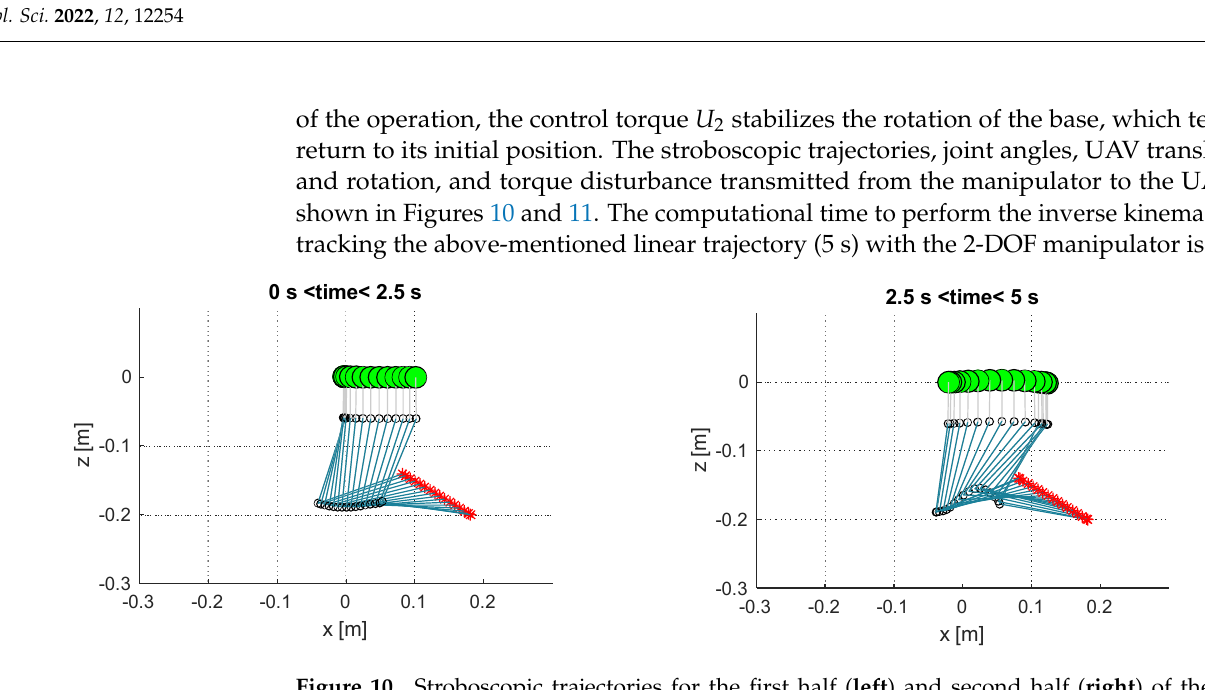
Figure 11. Manipulator ( top ) and UAV motions and torque disturbance ( middle and bottom ) for the 2-DOF UAM using the generalized Jacobian with external forces.